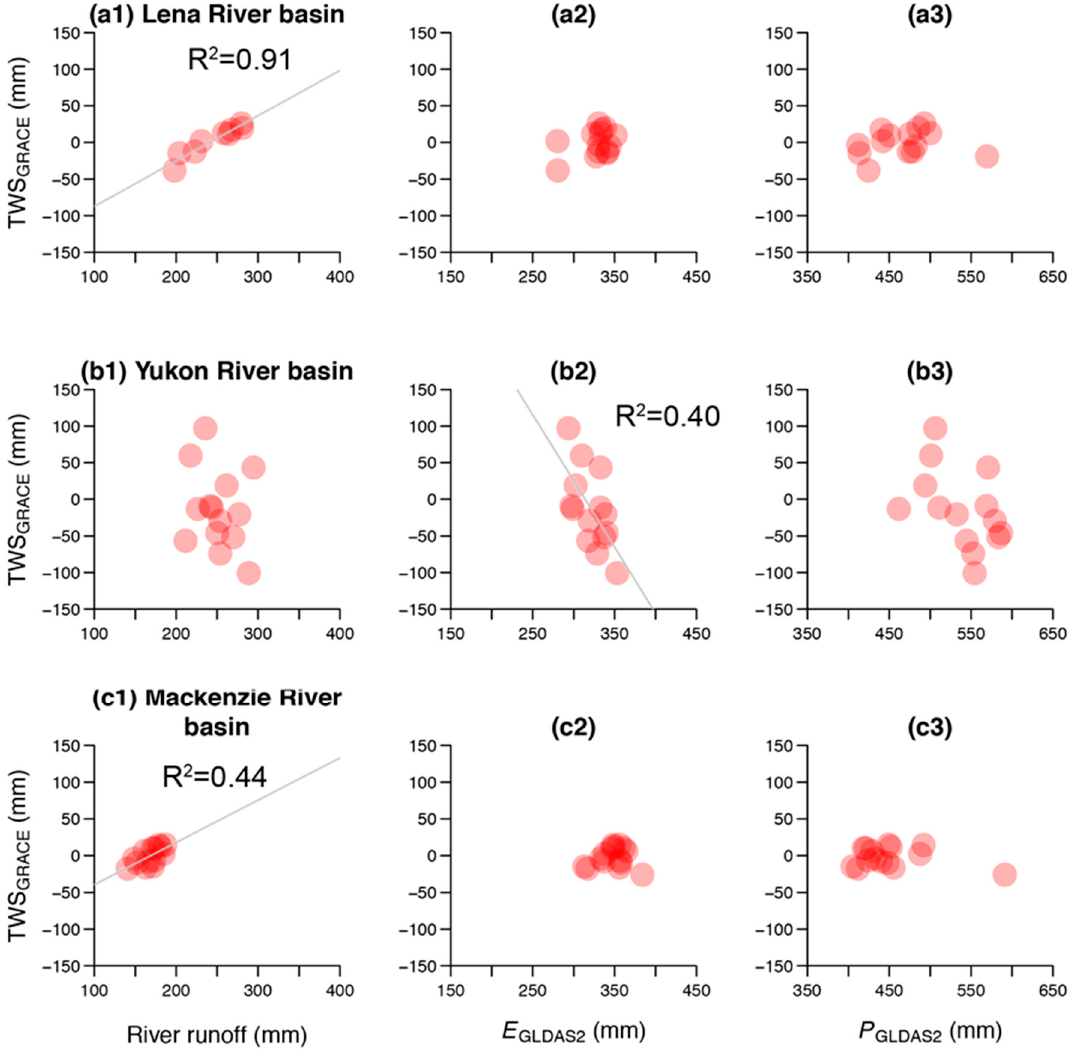
Figure 8. Relationships among the annual basin-scale TWS and the water balance components in the ( a ) Lena River basin, ( b ) Yukon River basin, and ( c ) Mackenzie River basin. Also shown are the (1) river runoff, (2) E GLDAS2 , and (3) P GLDAS2 . The gray lines denote linear regression lines when p < 0.05.